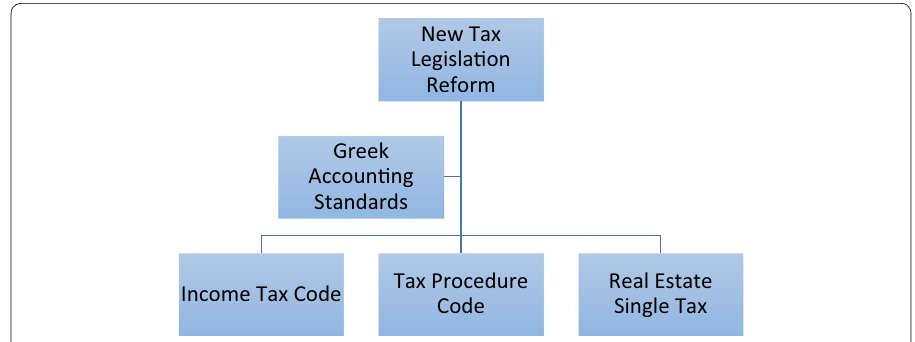
Fig. 1 The basic legal framework of the tax system in